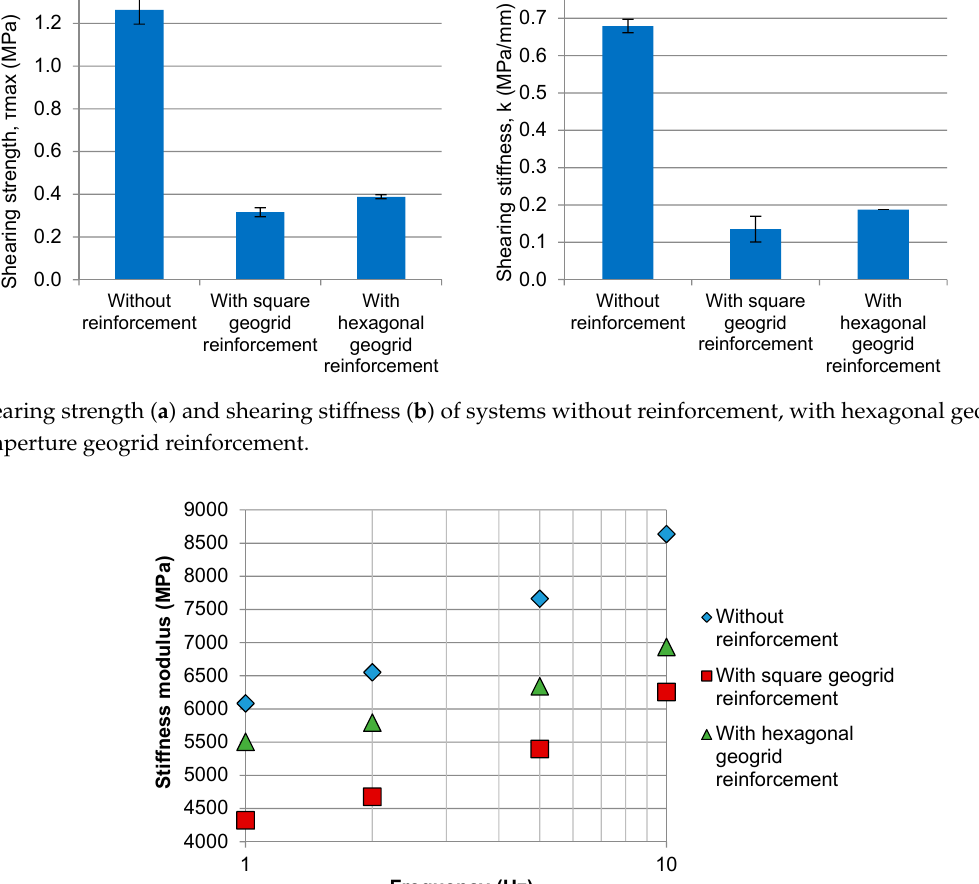
Figure 8. Comparison of the initial stiffness obtained at different load frequencies for double-layered asphalt concrete beams reinforced with square and hexagonal geogrids, as well as for reference samples without reinforcement.